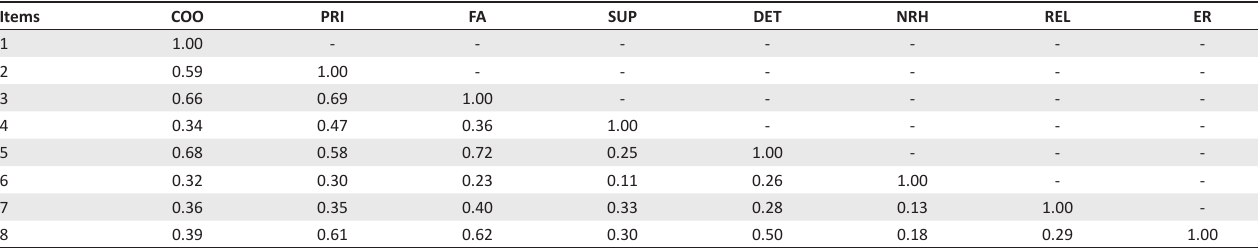
TABLE 4: The Phi matrix (validation sample).